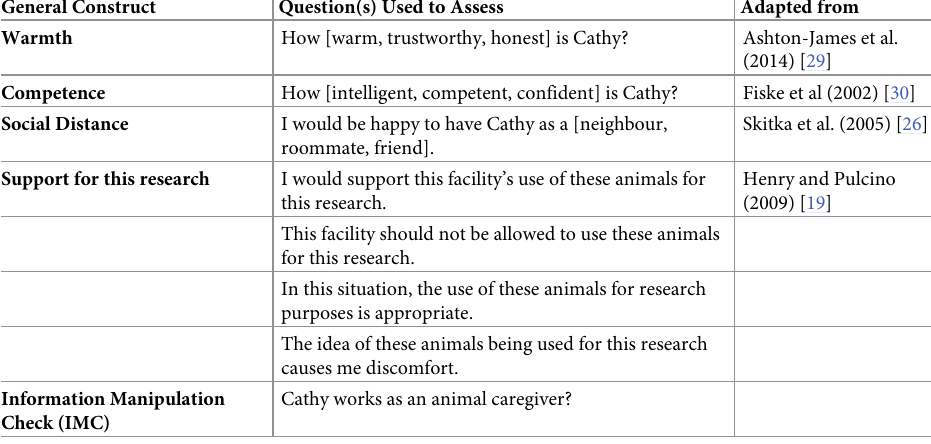
Table 1. Measures used to assess public perception of lab animal technicians based on transparency of the